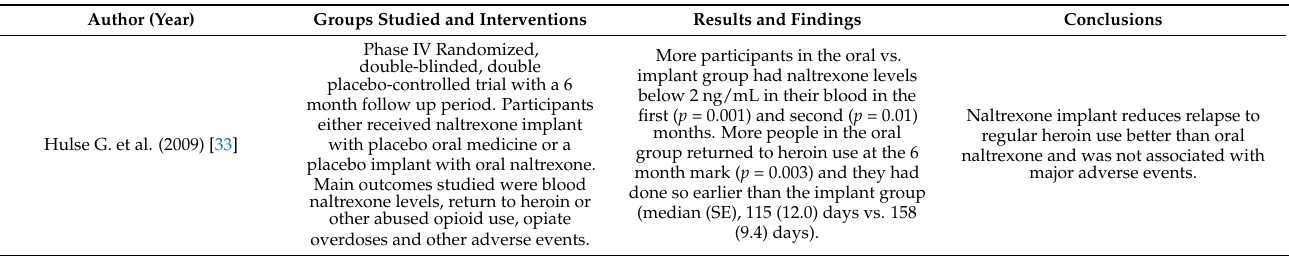
Table 2. Clinical Safety and